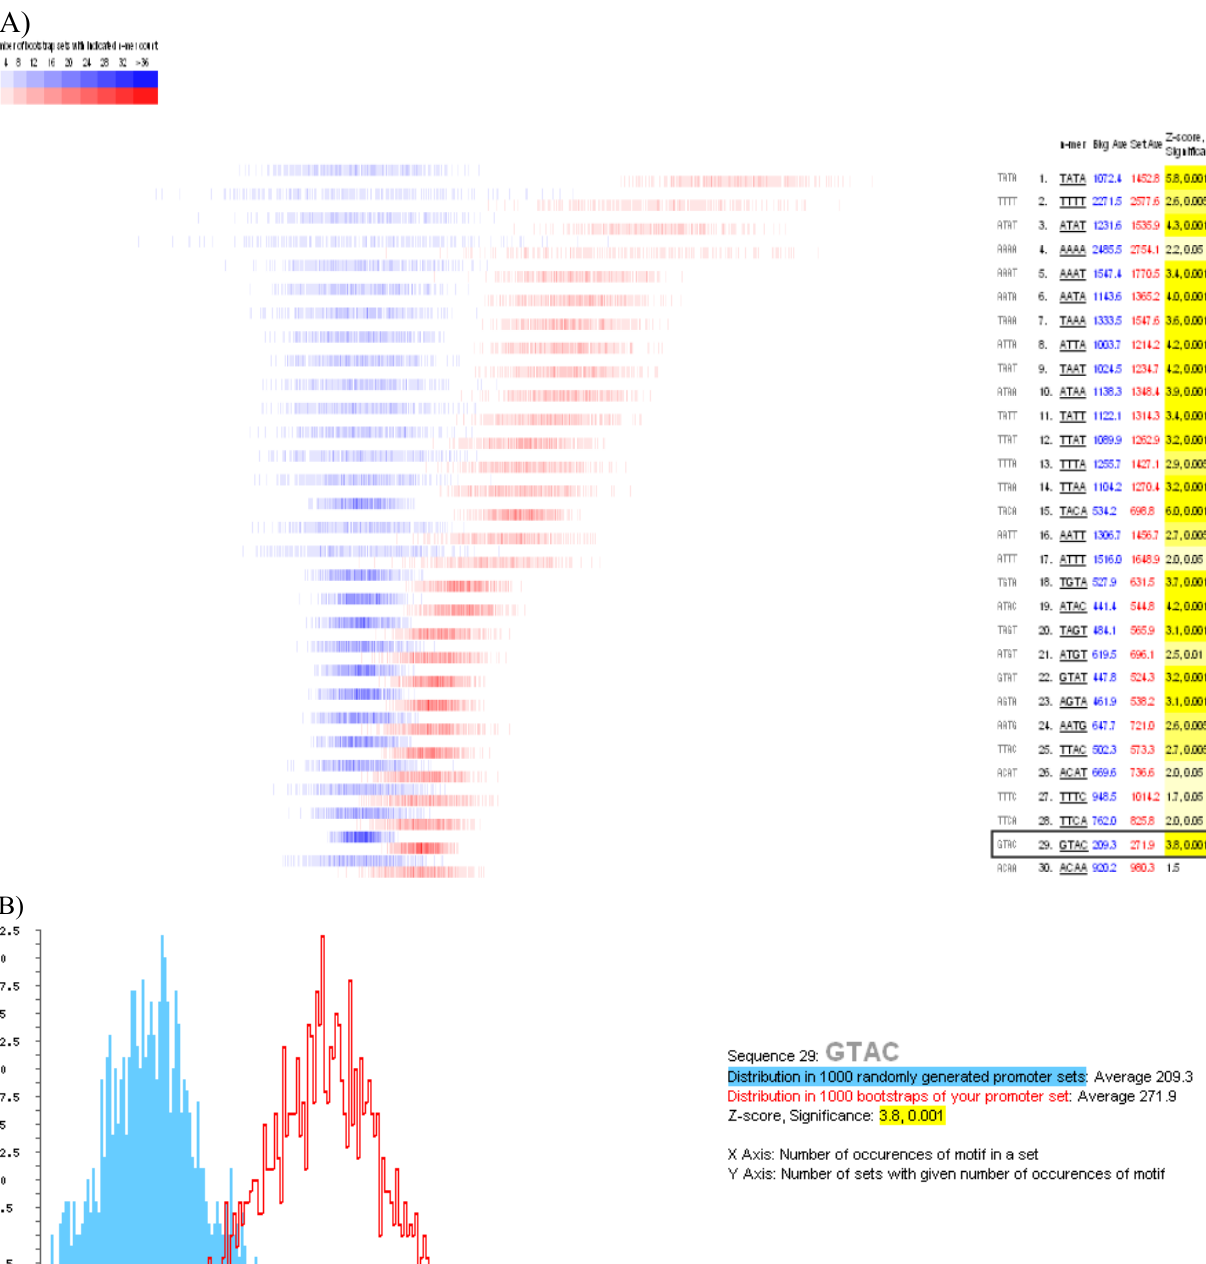
Figure 3. Promoter analysis of SPL co-expression genes. (A) The distribution of the occurrence of the GTAC motif in 1000 sets of SPL-correlated genes promoters randomly selected from the Arabidopsis genome. (B) Distribution in 1000 randomly generated promoter sets: Average 209.3. Distribution in 1000 bootstraps of our promoter set: Average 271.9. Z-score, Significance: